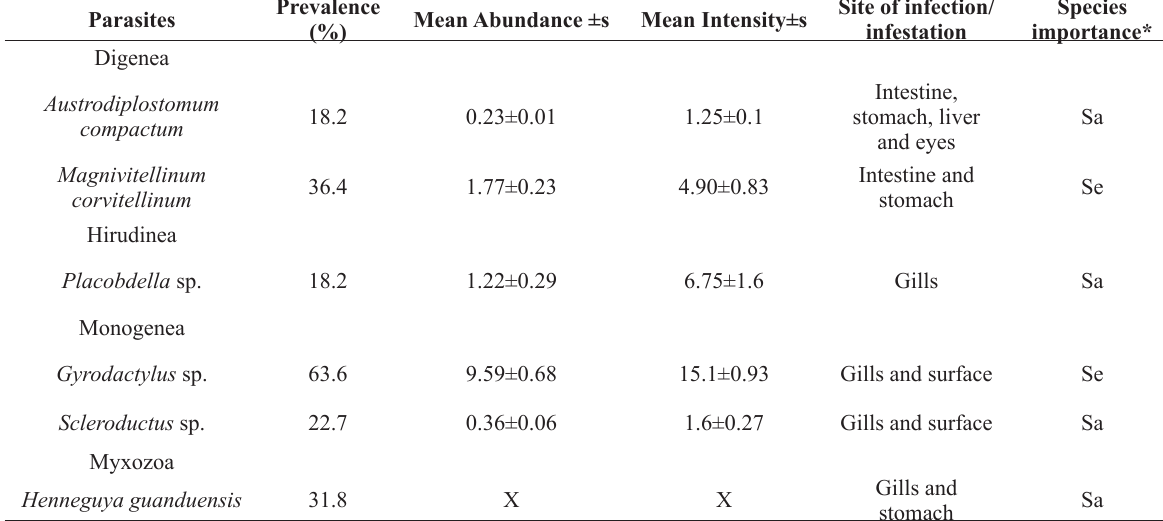
Prevalence, mean abundance, mean intensity and site of infection of the metazoan parasites of Hoplosternum littorale (Hancock 1828) collected in the Mouth of the Peixe River, Middle Tietê, São Paulo, Brazil. s= standard deviation.